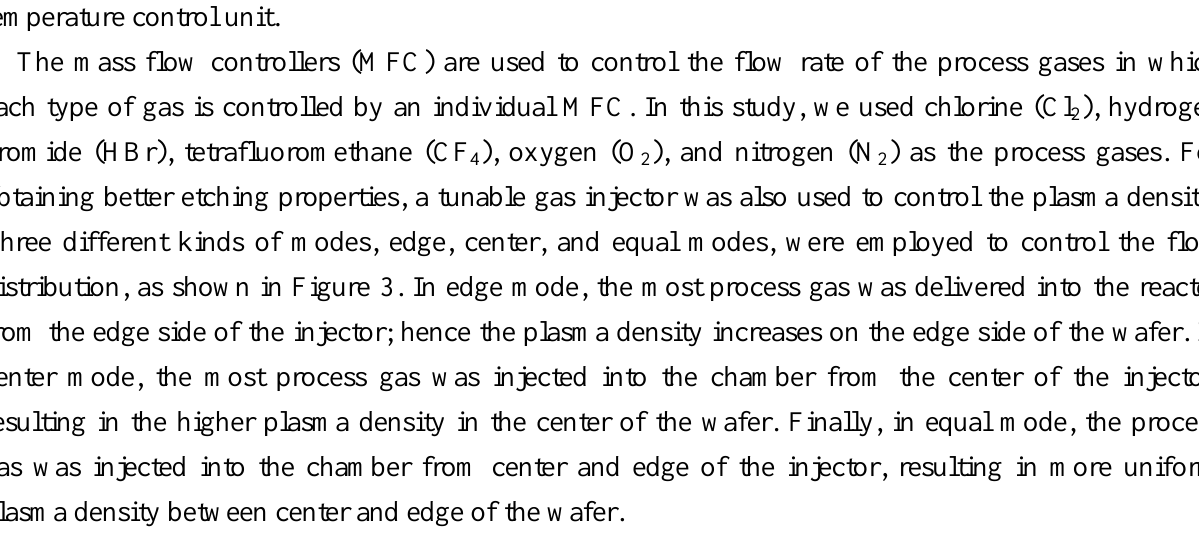
Figure 3. The schematic of three gas injector